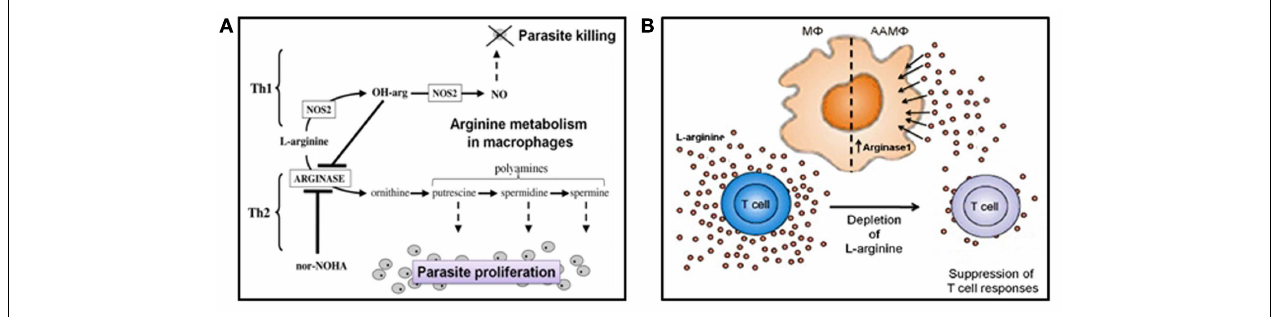
FIGURE 5 |Arginine and Leishmania survival. (A) L-arginine can have a direct influence on Leishmania intra-macrophage survival. L-arginine can influence the macrophage’s ability to host or kill Leishmania , depending on the cytokine milieu they are exposed to. In the classically activated state, macrophages can metabolize L-arginine into nitric oxide (NO) when they perceiveTh1 cytokines or pro-inflammatory mediators. Nitric oxide is potently toxic to Leishmania amastigotes. In direct contrast, alternatively activated macrophages can catabolise L-arginine into polyamines when they experienceTh2 cytokines/anti-inflammatory mediators. Polyamines are an essential food source for intracellular amastigotes. Promastigote secretory gel appears to promote the alternative activation of macrophages, corrupting them into “superfeeders” for the parasites